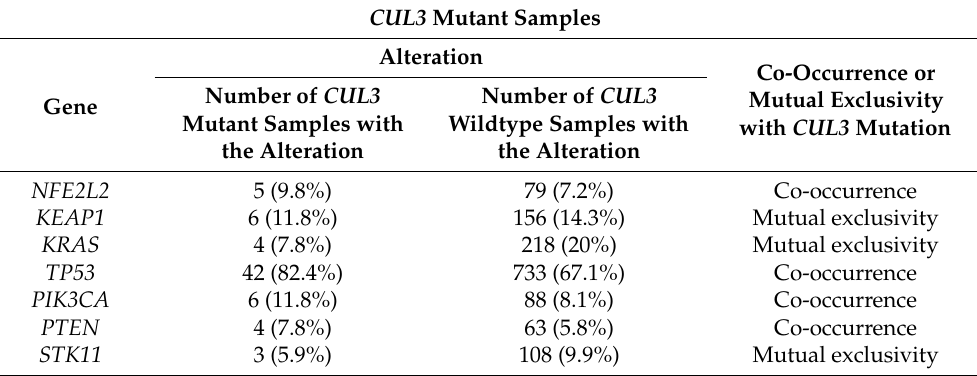
Table 6. CUL3 mutations occur alongside mutations in other genes in NSCLC